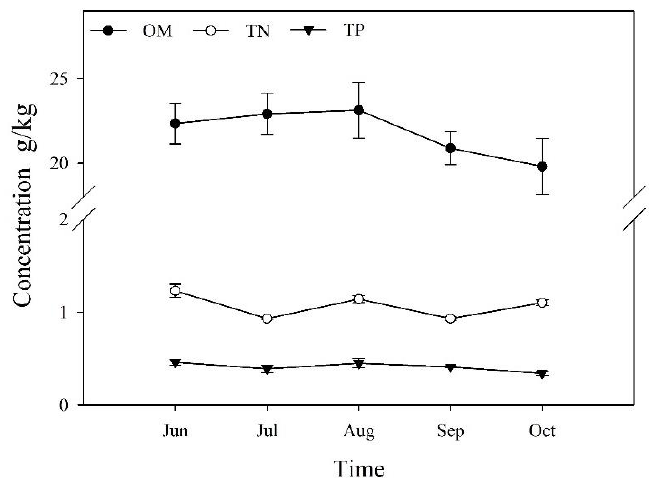
Figure 3. The organic matter (OM), total nitrogen (TN) and total phosphorus (TP) variations based on sediment used in the water treatment